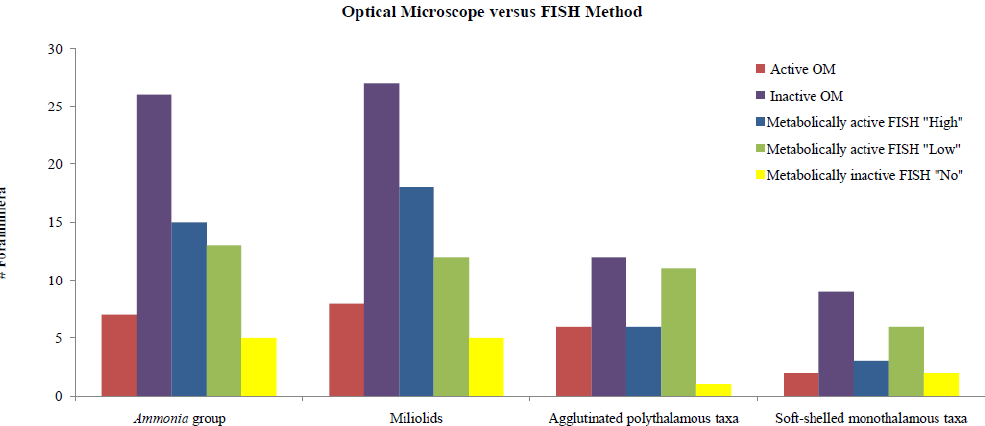
Fig. 4. Comparison between OM and FISH efficiency. “Active” OM=individuals that displayed pseudopodial activity; “inactive” OM=individuals that did not show pseudopods but, on the basis of cytoplasmatic color, presence of sediment in front of the aperture and of pigments inside the cell, may be alive but in a quiescent state. “Metabolically active” FISH=individuals that emitted fluorescence, reported as low or high basing on the signal intensity; “metabolically inactive” FISH=individuals that did not emit any visible fluorescence. Table 2. Results of FISH analyses performed on different taxonomic groups. Comparison between EUK 1209R and S17 probe results. See text for